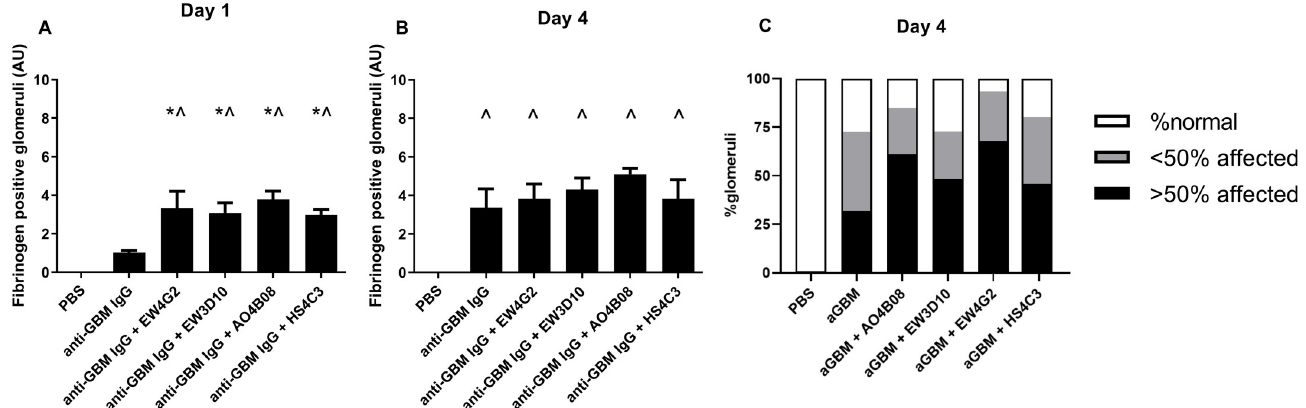
Fig 4. Co-injection of anti-HS antibodies increases fibrin deposition 1 day after induction of anti-GBM glomerulonephritis. Glomerular fibrin deposition after (A) 1 day and (B) 4 days of anti-GBM IgG-induced glomerulonephritis, analyzed by immunofluorescence staining and scored semi-quantitatively from 0–10 based on the percentage of glomeruli with positive staining. Glomerular lesions, identified as thrombosis and hyalinosis was scored on PAS stained renal sections for at least 63 glomeruli per mouse 4 days after injection with PBS, anti-GBM IgG alone or in combination with anti-HS antibodies as normal, containing < 50% affected or > 50% affected (C). Results are expressed as means ± s.e.m. from four mice in each group. ^ P < 0.05 vs. PBS-injected mice. � P < 0.05 vs. anti-GBM IgG- injected